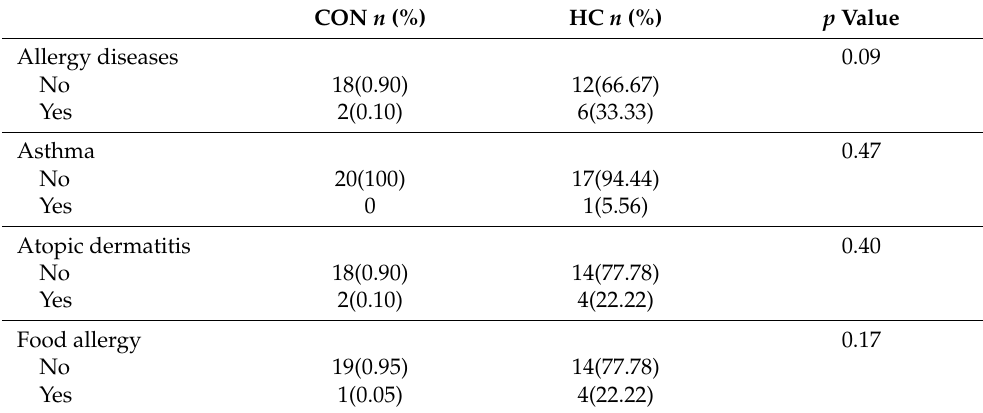
Table 1. Incidence of allergic